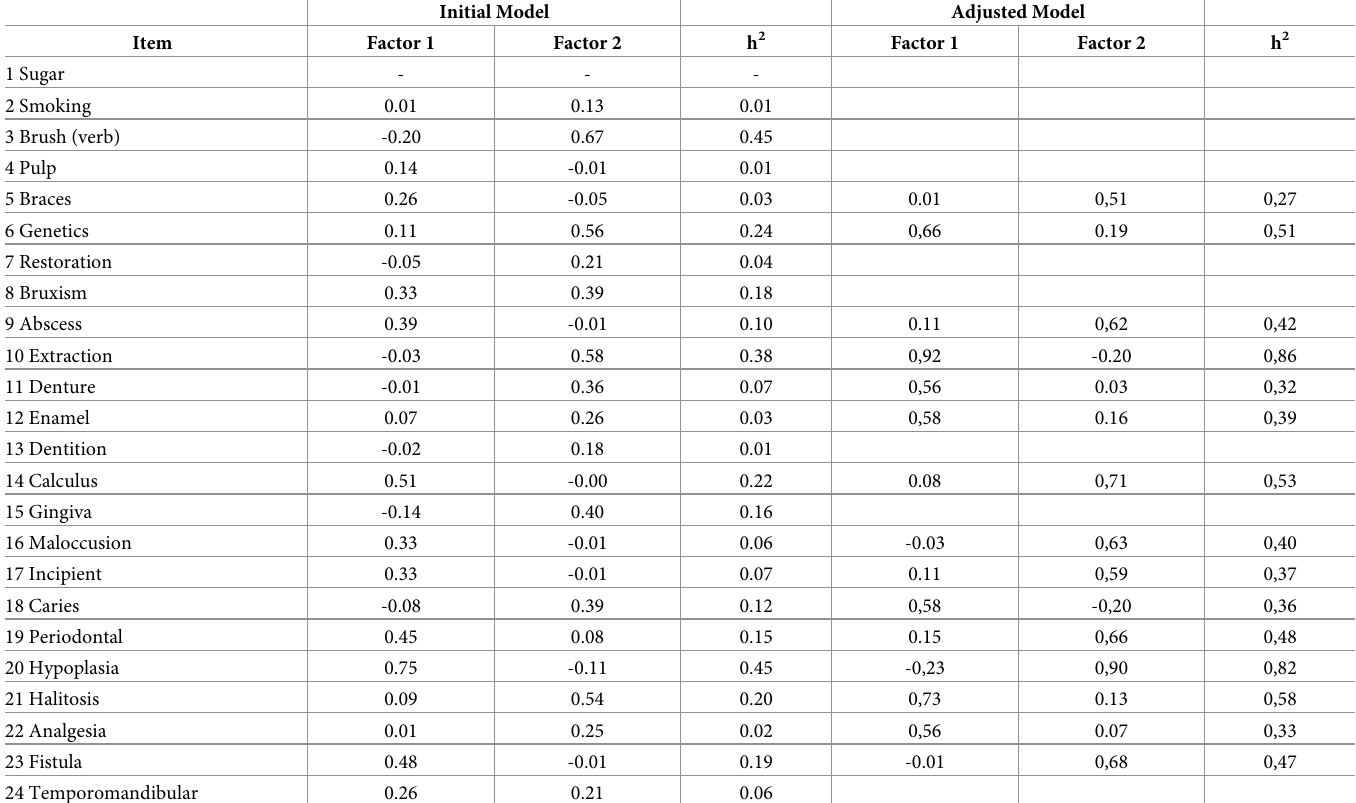
Table 1. Factorial loads and communalities (h 2 ) comparison between the initial model (OHLA-B with 24 items) and the adjusted model (OHLA-B with 15